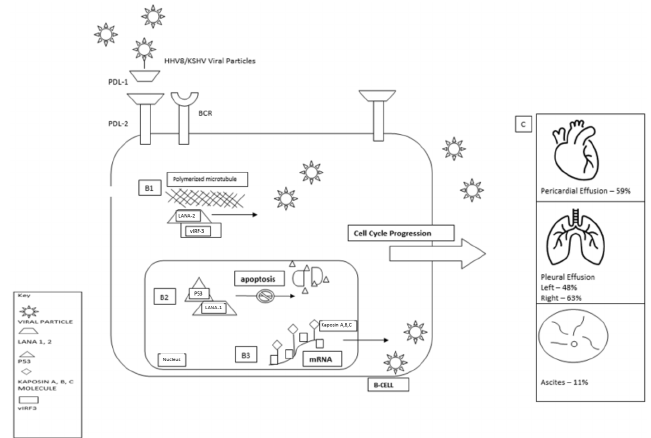
Figure 1. Pathogenesis Overview of PEL based on references [14,19]. P53: Tumor suppressor protein/transcription factor. Viral particle: Invasive HHV8, example of cell entry accessed via PDL-1. LANA-1,2: Latency associated nuclear antigen/oncoprotein. PD 1, 2: B cell surface marker. Kaposin molecule: representative of Kaposin protein A, B or C. A: Viral invasion of B-cell via PD-1/PDL-1 pathway. B1: Binding of LANA-2/vIRF3 complex to polymerized microtubules leads to transcription instability, facilitates viral proliferation. B2: Binding of LANA-1 to P53 prevent cell apoptosis facilitates viral proliferation. B3: Binding of Kaposi A, B, or C to variable sites of mRNA facilitates viral proliferation. C: Predominance of post-infectious effusion by organ site . 5.5. CAR-T Therapies in Other B-Cell Lymphoproliferative Disorders Axicabtagene ciloleucel (Axi-cel) is a chimeric antigen receptor (CAR) T-Cell agent, currently used as a third-line treatment for follicular and large B-cell lymphoma. ZUMA-1 is a phase 2 clinical trial across multiple centers, including 111 patients. Axi-cel was successfully manufactured for 99% of these patients and administered to 91%, resulting in an overall response rate (ORR) of 82% and a complete response rate (CRR) of 54%. These responses were sustained with a median follow-up of about 15 months and an OS at 18 months of 52% [73]. Brexucabtagene autoleucel (previously KTE-X19) is another CAR- T cell therapy, typically used for relapsed/refractory mantle cell lymphoma. This therapy was used in the 74-patient ZUMA-2 trial, ultimately showing a 12-month progression free survival (PFS) of 61% and OS of 83%. The most common adverse events were those effects